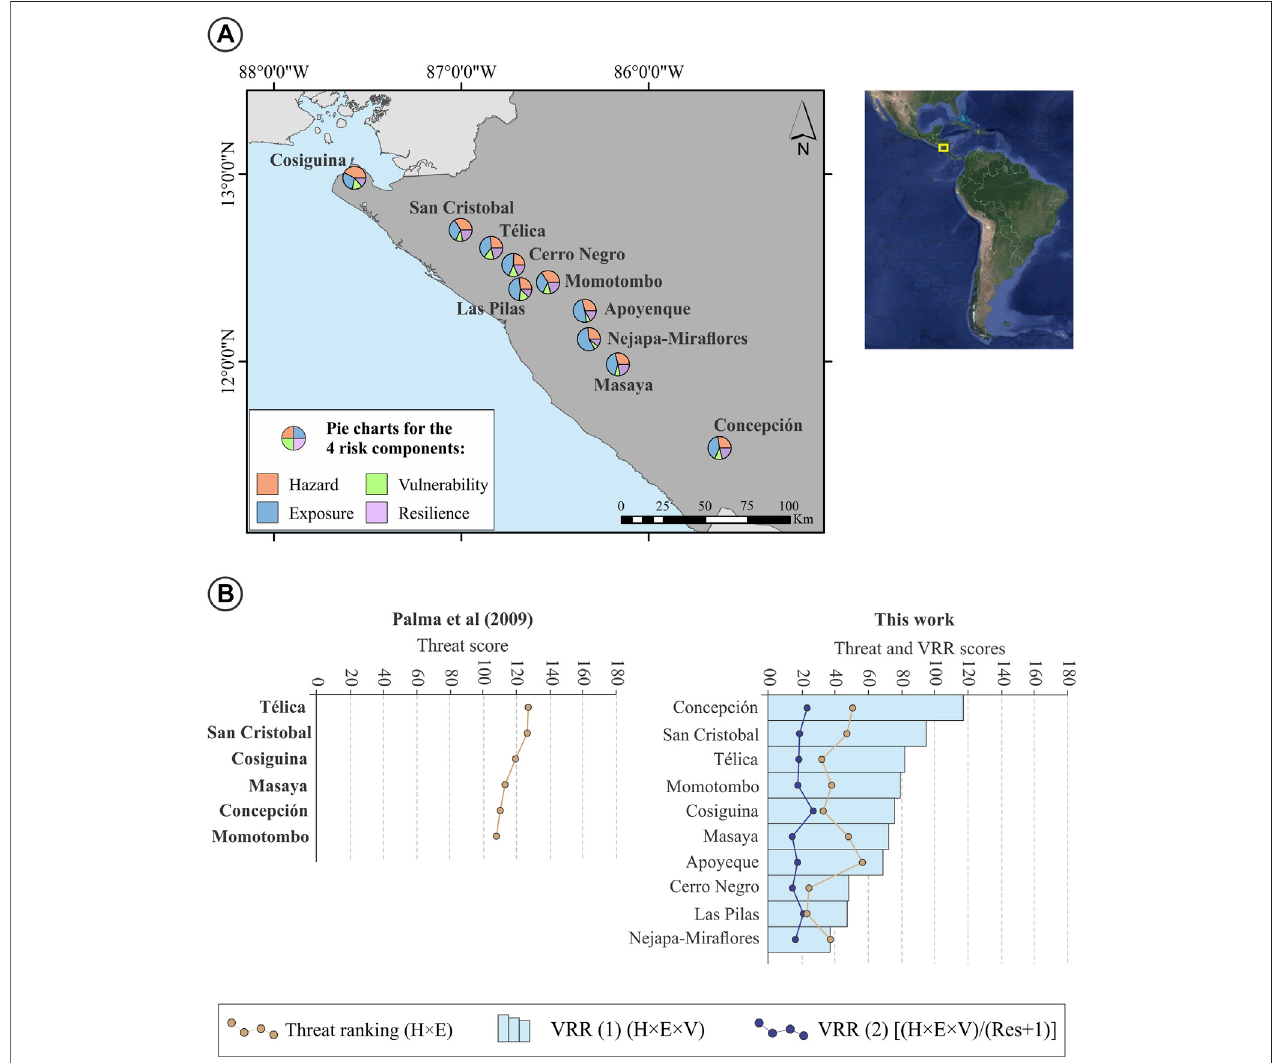
FIGURE 9 | (A) Location of the Nicaraguan volcanic systems with volcanic activity recorded in the last 1,000 years with their respective pie charts for the fourrisk components (hazard, exposure, vulnerability and resilience). (B) Comparative diagrams between previously published ranking (Palma et al., 2009) and our results. It is important to note that the ranking of Palma et al. (2009) was developed for some of the Central America volcanic systems based on the threat (according to Ewert et al., 2005; Ewert., 2007), while our work provides 2 different rankings: VRR (1) and VRR (2).